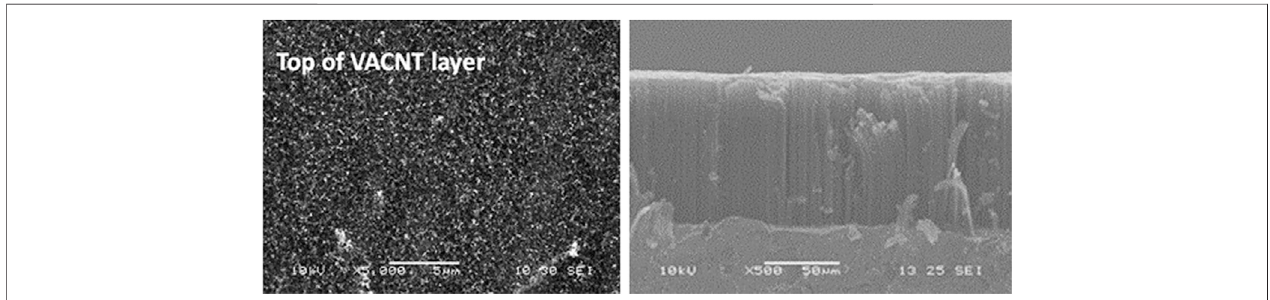
FIGURE 4 | SEM images of VACNTs grown on 15 nm Al coated Cu foil substrate. Top view (Left, scale bar (cid:2) 5 µm) and side view (Right, scale bar (cid:2) 50 µm).